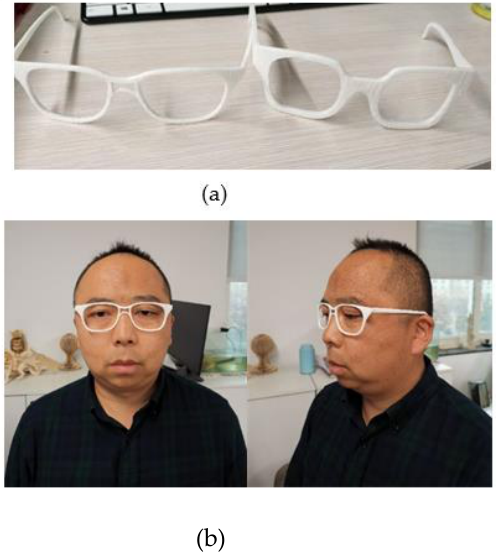
Figure 17. ( a ) 3D printed prototype; ( b ) evaluation of comfort.